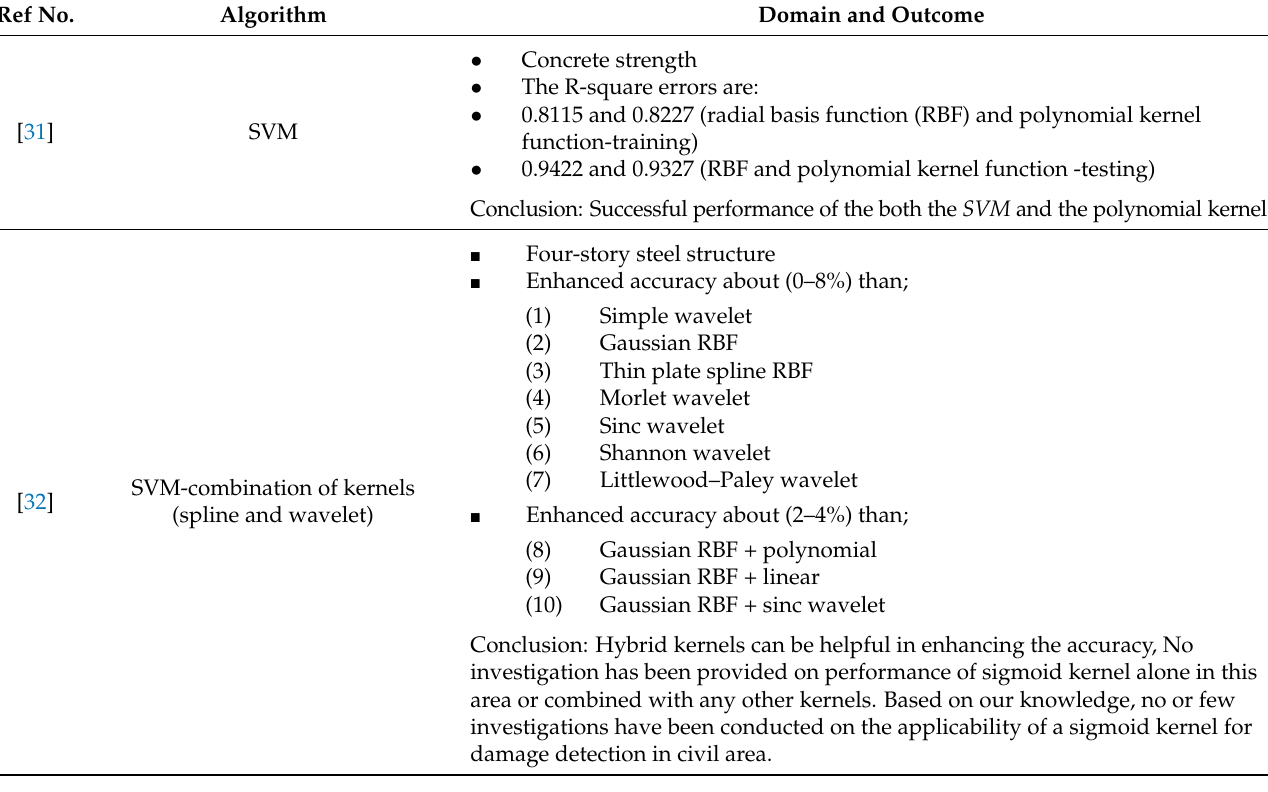
Table 1. Summary of SVM studies based on